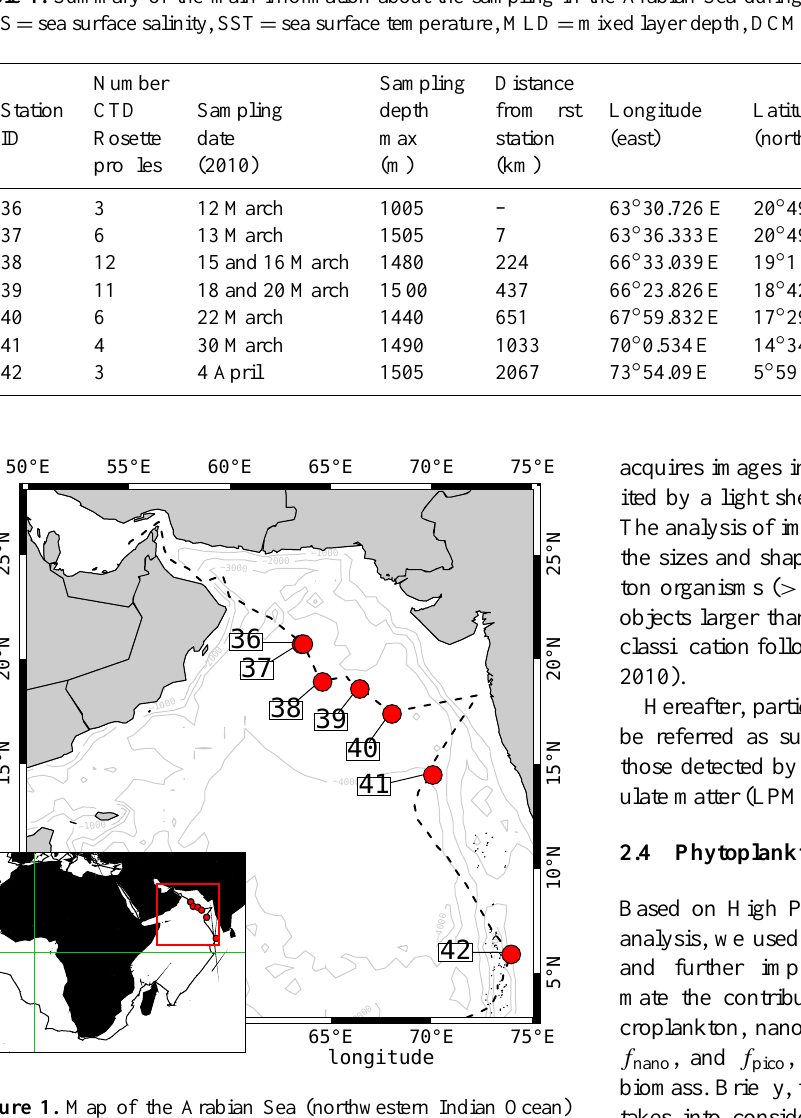
Table 1. Summary of the main information about the sampling in the Arabian Sea during the TARA oceans expedition in March 2010